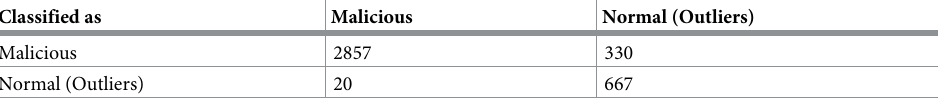
Table 9. Confusion matrix for outlier detection during one-class SVM training—Malware and APT